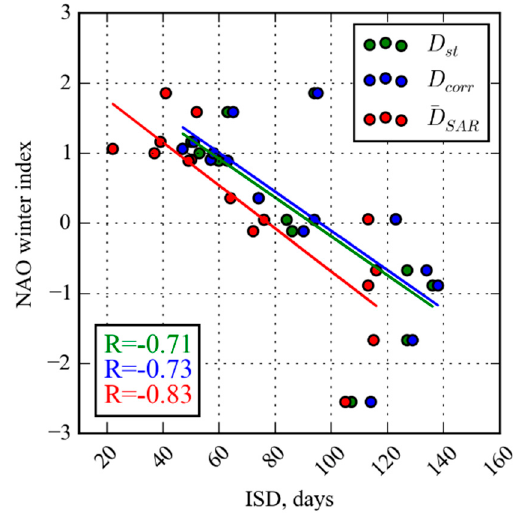
Figure 16. Scatterplots of the ice season duration values derived from the coastal records ( D st , green points), joint use of the coastal and satellite data ( D corr , blue points), and spatially-averaged satellite data ( D SAR , red points) compard to the NAO winter index.